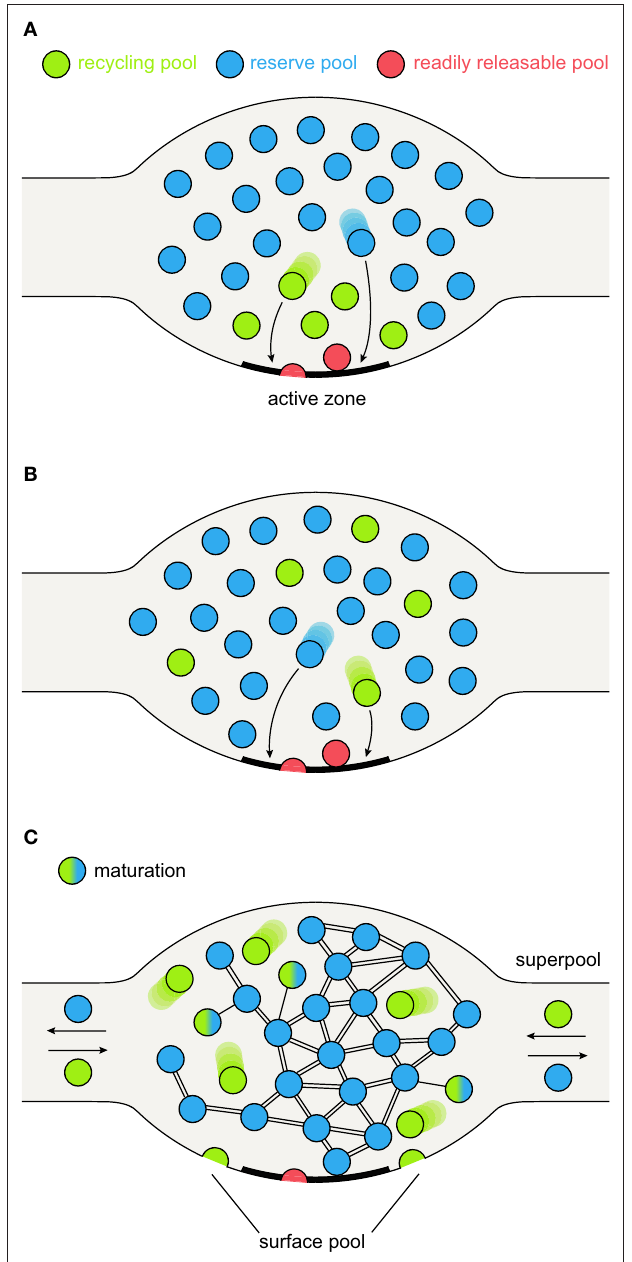
Figure 1 | Synaptic vesicle pool models. (A) The classical model of three distinctly localized synaptic vesicle pools. The readily releasable pool (RRP; depicted in red) consists of the vesicles docked at the active zone and primed for release. After depletion of the RRP, the recycling pool vesicles come into play (green): these vesicles were thought to be located directly behind the RRP. Under moderate stimulation conditions, they are recruited to the active zone (left arrow) and released. Very high stimulation causes the depletion of the recycling pool and recruits the reserve pool vesicles (blue) from areas even further away from the active zone (right arrow). (B) A pool model taking into account the spatial intermixing of vesicles (Rizzoli and Betz, 2005). In contrast to the previous model, in which localization within the nerve terminal determines release kinetics and consequently pool affiliation, here the recycling and reserve pool vesicles are thought to be spatially (but not functionally) intermixed. Upon arrival of an action potential, RRP vesicles (which are in this model only the “lucky” recycling pool vesicles finding themselves docked and primed at the active zone) are released first, followed by release of recycling pool vesicles (right arrow). As above, continuous stimulation at high-frequency results in recycling pool depletion and recruitment of reserve pool vesicles (left arrow). (C) A new pool model implementing recent findings. As above, recycling and reserve pool vesicles are thought to be spatially intermixed, but display different mobilities: recycling pool vesicles are highly mobile; the movement of reserve pool vesicles is restricted by binding to some scaffolding molecule. With time, recycling pool vesicles can “mature” into reserve pool vesicles, by binding the scaffolding molecule(s) and integrating into the vesicle cluster, as indicated by the green-blue intermediate forms. These are not connected to the cluster as tightly as the reserve pool vesicles (indicated by single or double bonds). Recycling pool vesicles reach the active zone, due to their permanent mobility; stimulation does not “move” them toward the active zone, it just allows them to fuse. Furthermore, the surface pool of fused vesicles is indicated; they would be endocytosed to form part of the recycling pool (see main text). The frequent exchange of both recycling and reserve vesicles between synapses forms what has been termed a super-pool (see main